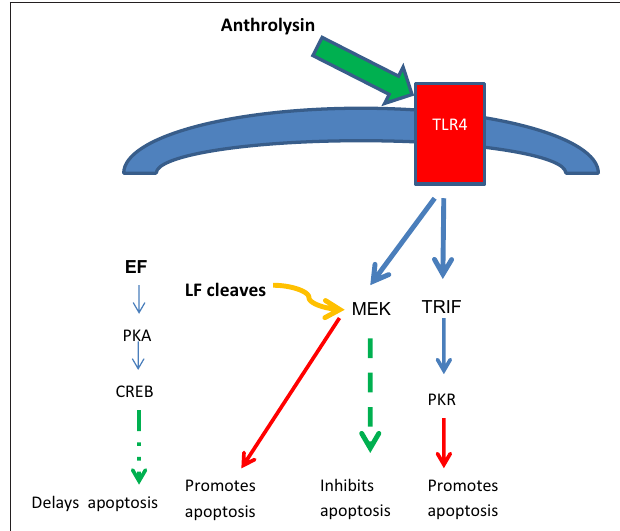
FIGURE 2 | Opposing effects of anthrolysin, LF and EF on host cell apoptosis. Anthrolysin secreted by B. anthracis binds surface TLR4 receptors with downstream signaling through either TRIF and PKR to promote apoptosis, or through MEK to inhibit apoptosis; the latter inhibitory effect is opposed by LF cleaving MEK, thus promoting apoptosis. EF signals through the PKA and CREB pathway which has benefit in delaying apoptosis until the phagocytic host cell reaches the lymph node, an optimal niche for germination with further toxin release. Glossary: PKR, protein kinase regulated by RNA; PKA protein kinase A; CREB, cAMP response-element-binding protein; TRIF, TIR-domain-containing adapter-inducing interferon- β